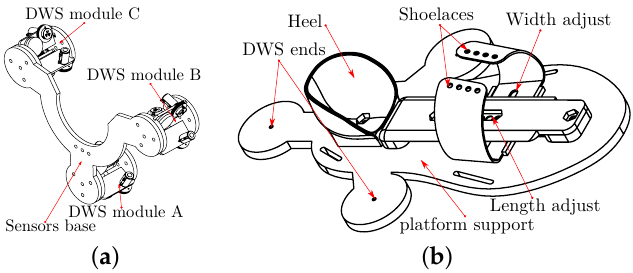
Figure 18. Base and platform: ( a ) DWS modules support ( b ) platform with foot’s size